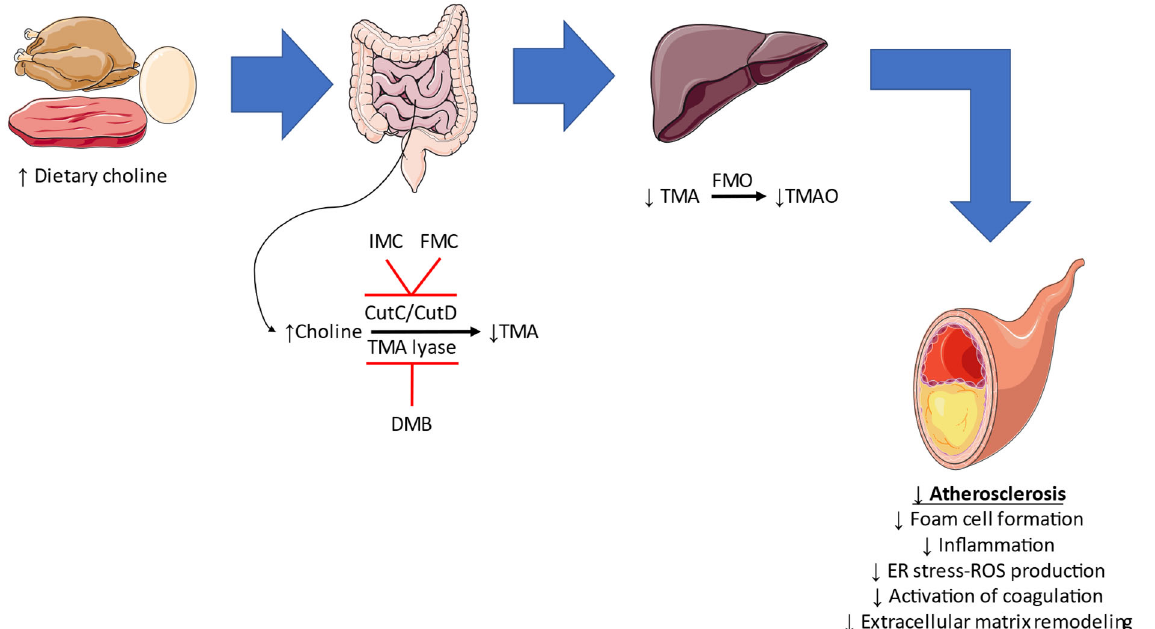
Figure 4. The effect of TMAO inhibition in atherosclerosis. Consumption of a high ‐ choline diet leads to its conversion to trimethylamine (TMA) in the gut, with the aid of CutC/CutD and TMA ‐ lyase. Inhibition of these enzymes by iodomethylcholine (IMC)/fluoromethylcholine (FMC) and 3,3 ‐ dimethyl ‐ 1 ‐ butanol (DMB) leads to lower trimethylamine N ‐ Oxide (TMAO) production in the liver. As a result, atherosclerosis may be attenuated through multiple mechanisms. FMO: flavin ‐ containing monooxygenase, ER: endoplasmic reticulum, ROS: reactive oxygen species. Flavonoids, a large class of polyphenolic compounds, are present in tea, citrus fruit, citrus fruit juices, berries, red wine, apples, and legumes. In flavonoid aglycones, bai ‐